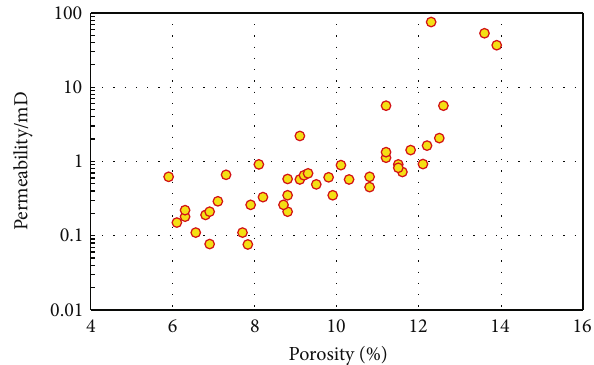
Figure 7: Cross plot of permeability and porosity of rock samples from the study